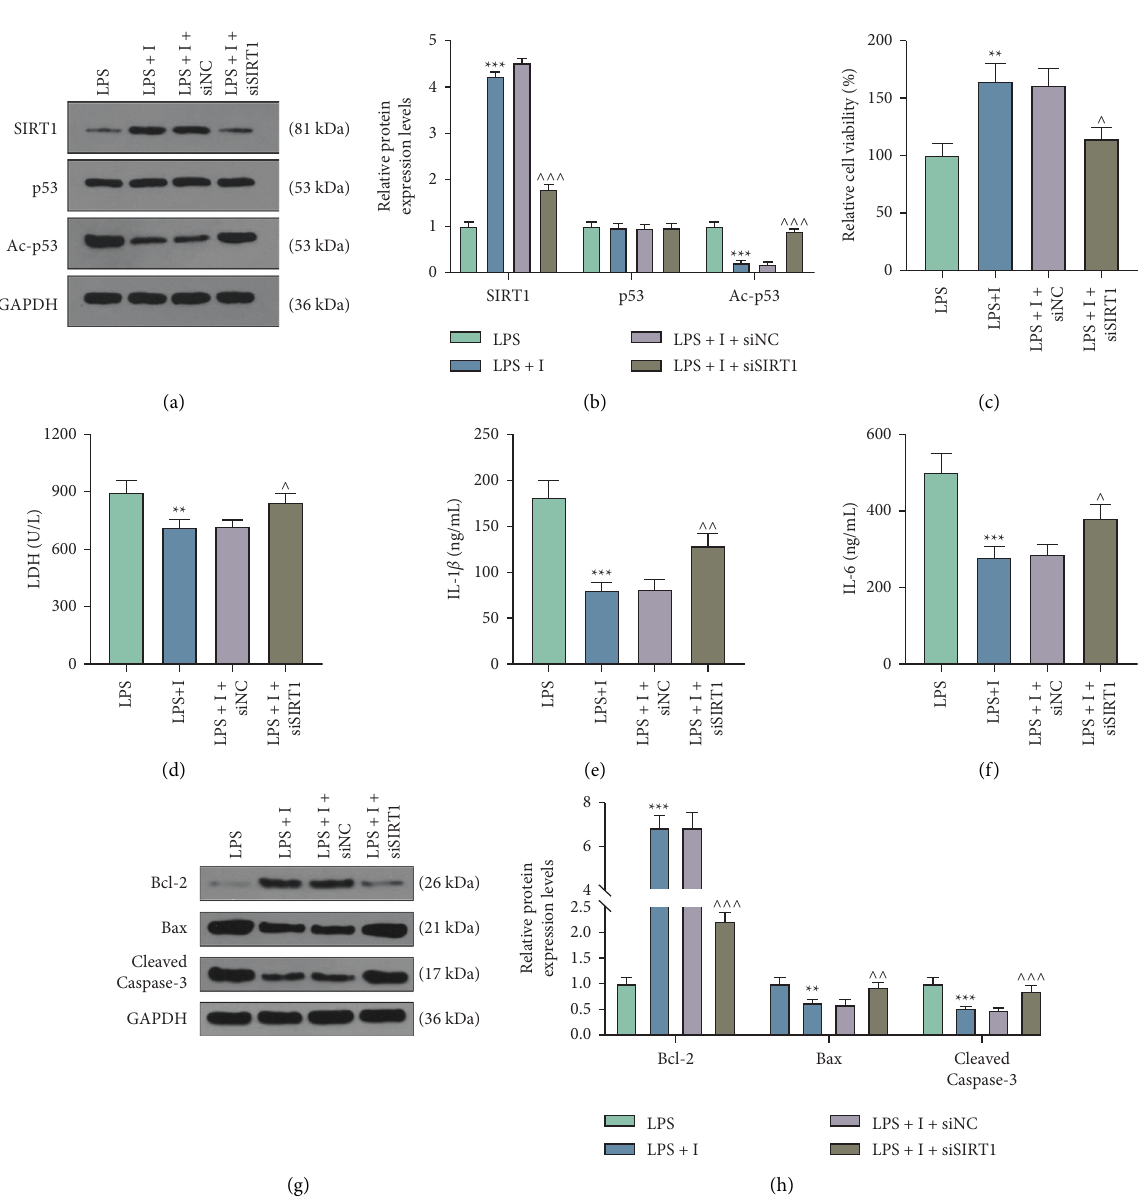
Figure 4: miR-197 participated in LPS-induced cardiomyocyte injury by modulating SIRT1. (a, b) To affirm the effect of transfection with siSIRT1, a western blot was conducted to measure the protein level of SIRT1. GAPDH was used as the loading control. (c) CCK-8 was used to examine cell viability. (d) After transfection with siSIRT1, the LDH assay kit was employed to measure levels of LDH. (e, f) ELISA was applied for evaluating IL-1 β and IL-6 levels. (g, h) Western blot was utilized to examine the protein levels of apoptosis-related genes Bcl-2, Bax, and cleaved caspase-3. The abovementioned experiments were repeated at least three times. ∗∗ p < 0 . 01; ∗∗∗ p < 0 . 001 vs. LPS; ∧ p < 0 . 05; ∧∧ p < 0 . 01; ∧∧∧ p < 0 . 001 vs. LPS +I+siNC. CCK-8, cell counting kit-8; qRT-PCR, quantitative real-time polymerase chain reaction; LDH, lactate dehydrogenase; ELISA, enzyme-linked immunosorbent assay; SIRT1, silent information regulator 1; LPS, lipopolysaccharide; IL-1 β , interleukin-1 β ; IL-6, interleukin-6; Bcl-2, B-cell lymphoma-2; Bax, BCL2-associated X; GAPDH, glyceraldehyde-3-phosphate dehydro- genase; siSIRT1, small interfering RNA against SIRT1; I, miR-197 inhibitor; IC, inhibitor control; NC, negative